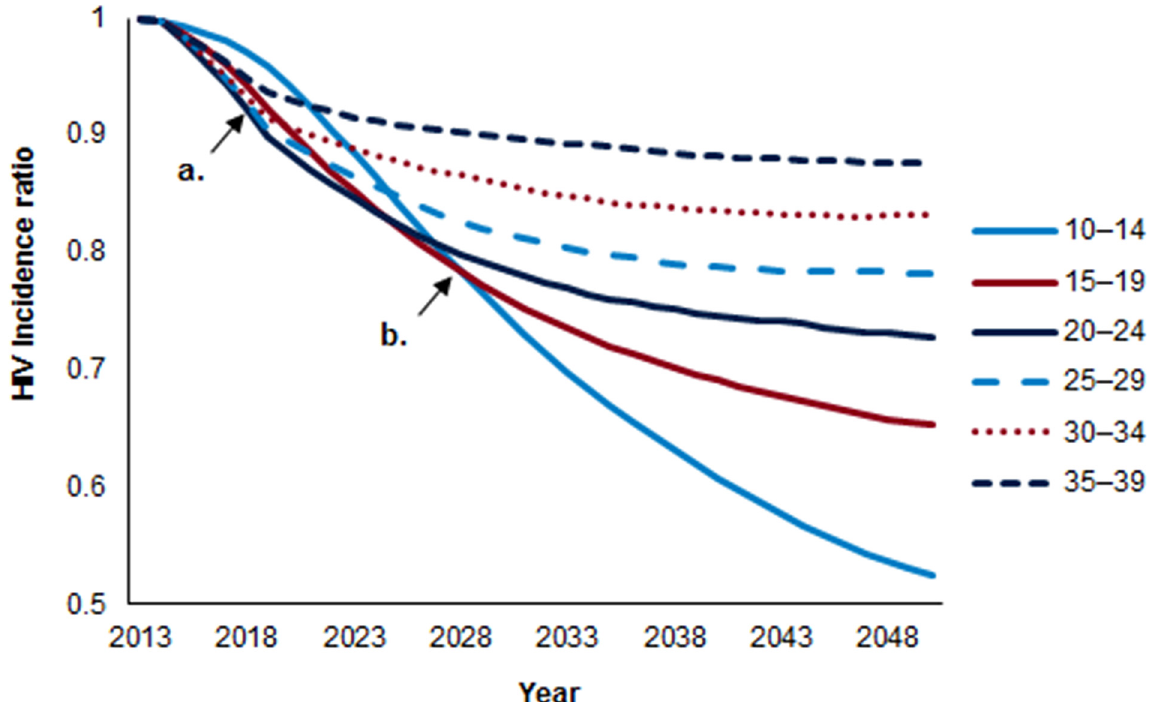
Fig 1. Modeled relative reduction in HIV incidence by scaling up VMMC for individual age groups, compared with no scale- up of VMMC over baseline levels, 2014 – 2050. (a) immediacy of impact (5 years). (b) magnitude of impact (15 years). The HIV incidence ratio represents the incidence in the scale-up scenario divided by the HIV incidence in a population where circumcision is not scaled-up over baseline levels. Each line represents the HIV incidence ratio under a scenario in which only the indicated five- year age group is circumcised. Marker a represents a five-year period from the base year (2014). Marker b represents a 15-year period from the base year.